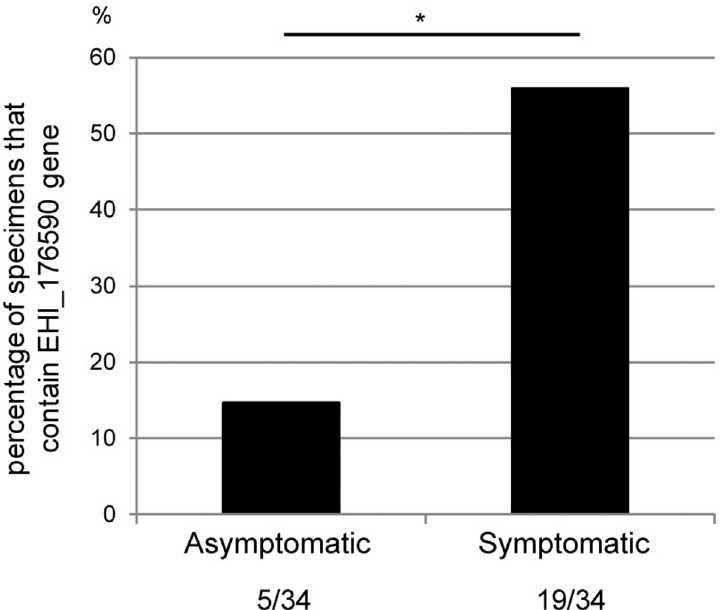
Fig 4. Existence of the EHI_176590 gene in E. histolytica clinical isolates. DNA, extracted from clinical samples (stool or ALA pus) obtained from symptomatic and asymptomatic E. histolytica-infected individuals, was PCR- amplified with EHI_176590 gene-specific primers to examine the presence or absence of the gene. A total of 34 samples, from symptomatic (diarrhea and ALA) and asymptomatic cases, were analyzed. The percentages of PCR- positive samples are shown. (cid:3) : p-value = 0.0004 by Fisher’s exact test.